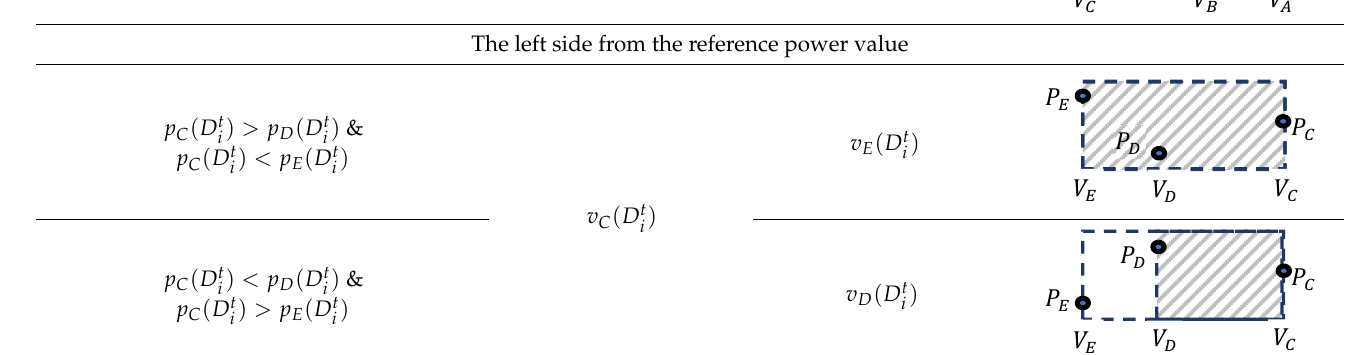
The left side from the reference power value